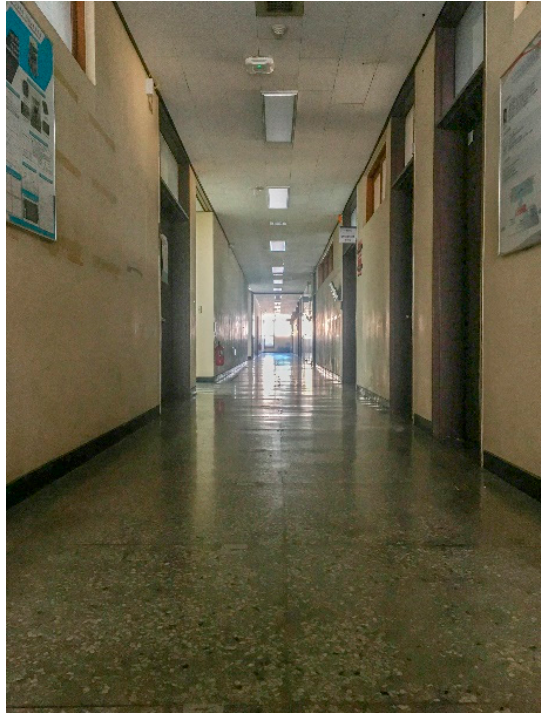
Figure 8. The environment for the walking experiment.